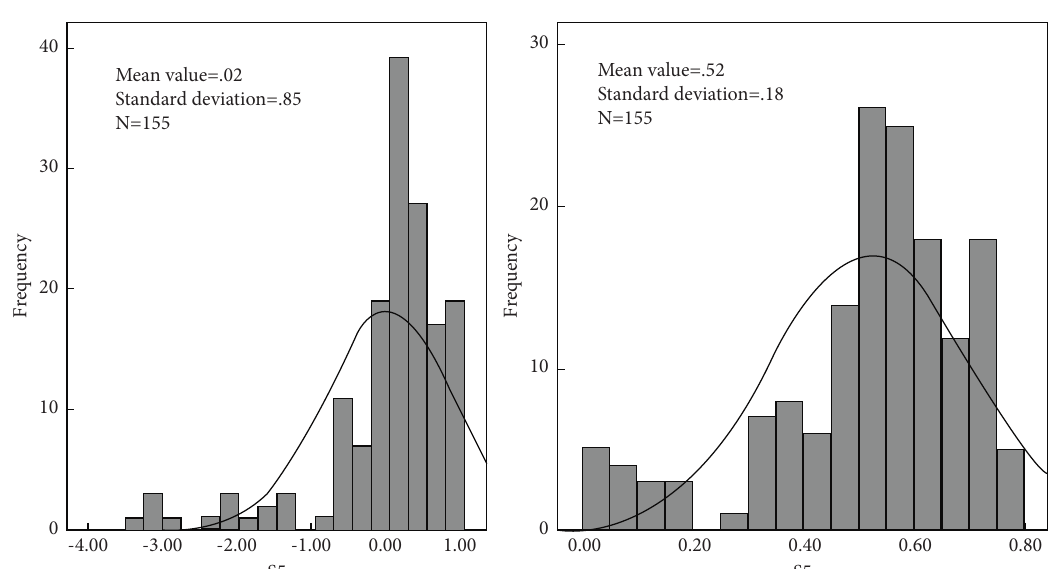
Figure 1: Histogram comparison of index S5 before and after sigmoid